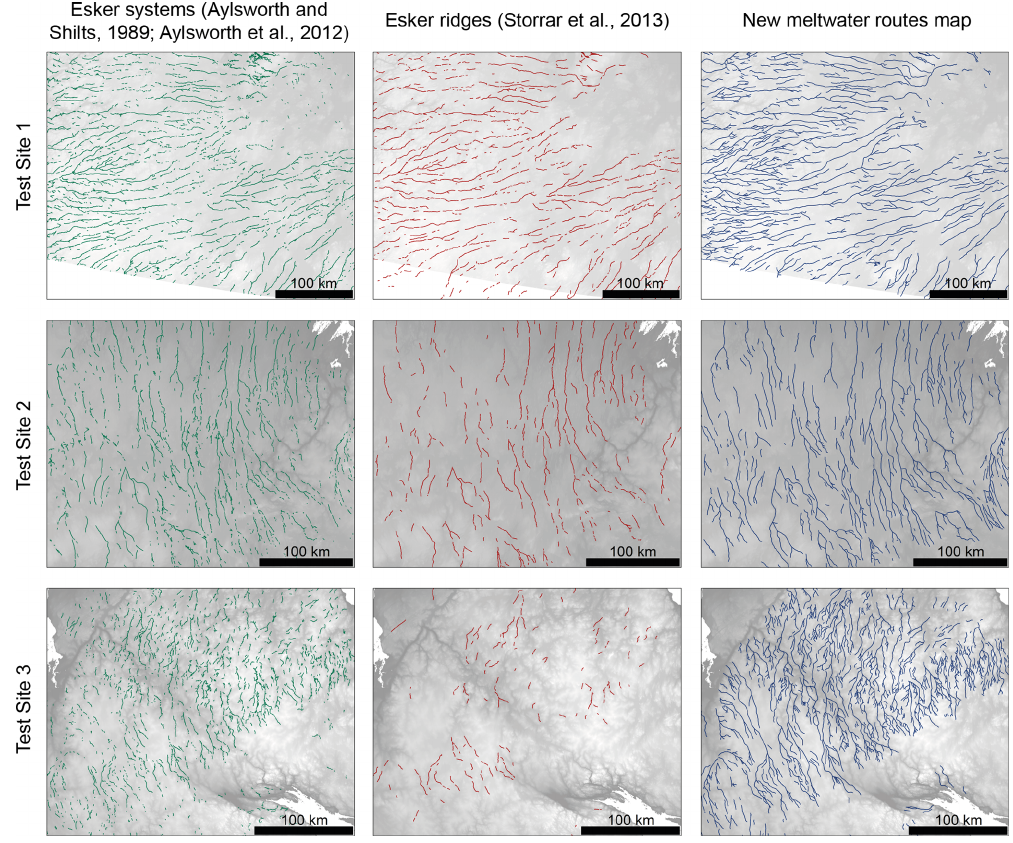
Figure 7. Comparison of existing maps of esker systems (green) from air photo interpretation (Aylsworth and Shilts, 1989; Aylsworth et al., 2012), esker ridges (red) from Landsat imagery (Storrar et al., 2013) and the new meltwater routes from the ArcticDEM (blue). Mapping of meltwater routes includes all traces of subglacial meltwater flow (eskers, eskers with lateral splays, meltwater tracks and meltwater channels). The locations of test site 1, test site 2 and test site 3 are identified in Fig. 5. Digital elevation models (DEMs) created from the Canadian Digital Elevation Model (CDEM). © Ottawa, ON: Natural Resources Canada